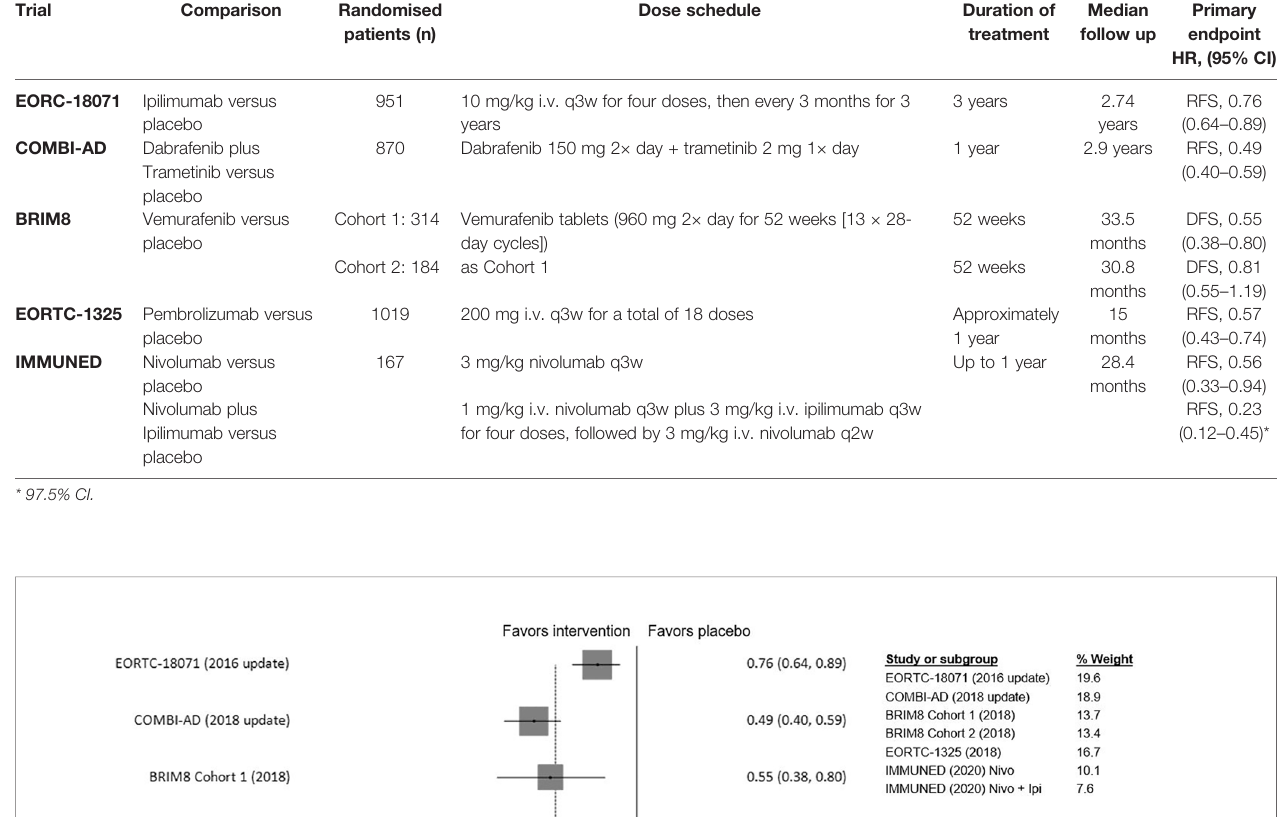
TABLE 1 | Overview of the characteristics of the included studies. Trial Comparison Randomised